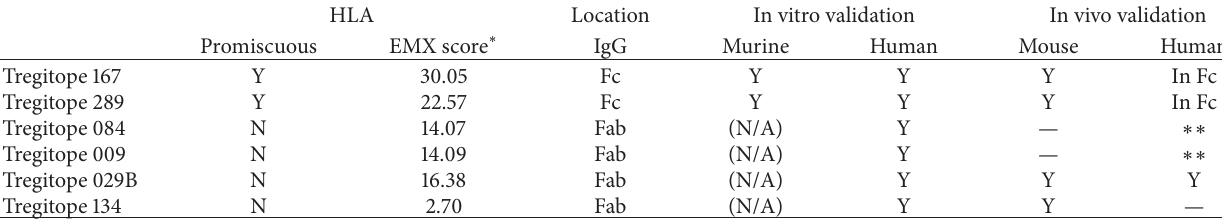
Table 1: Partial list of previously identified human IgG tregitopes. HLA Location In vitro validation In vivo